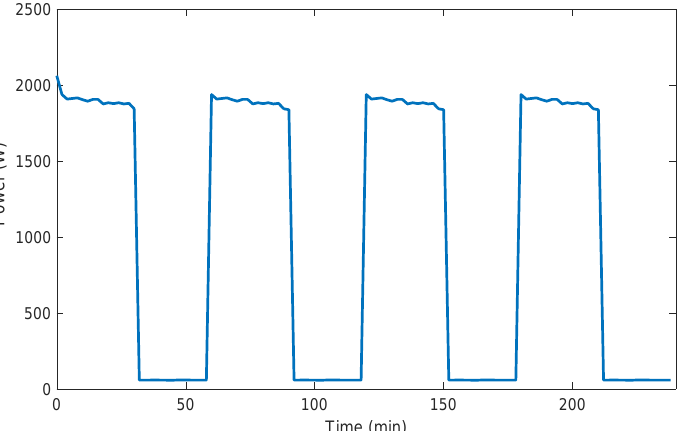
Figure 2. Power consumption profile of a kettle (1000 W and 1.2 lt capacity).